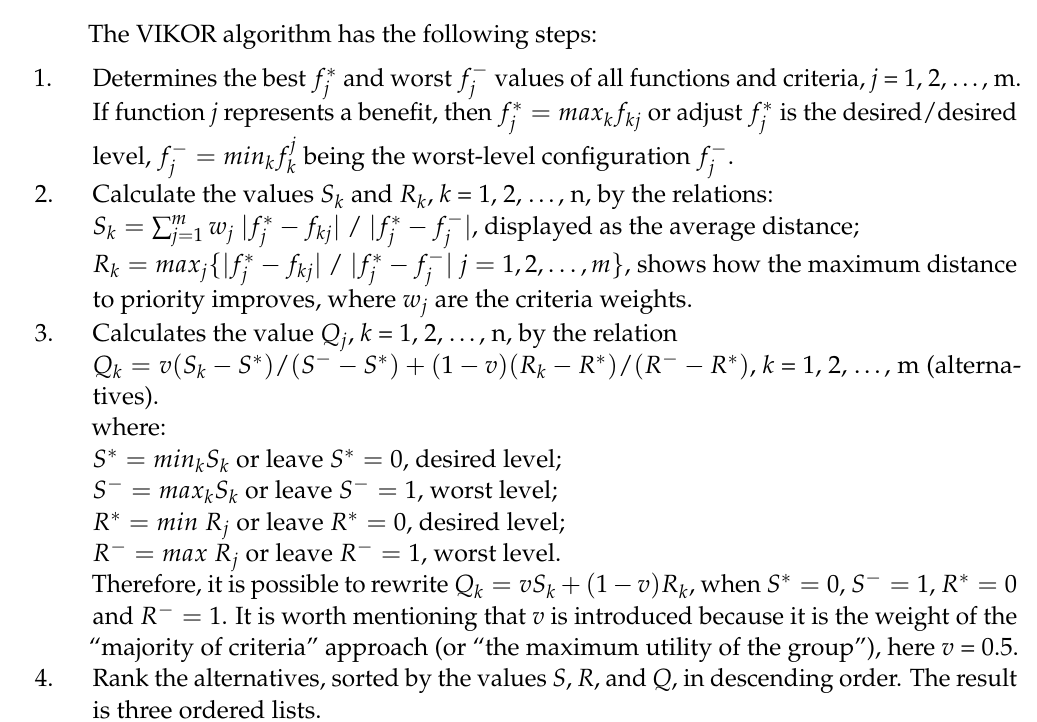
Figure 3. Optimal and Adjustment Solutions